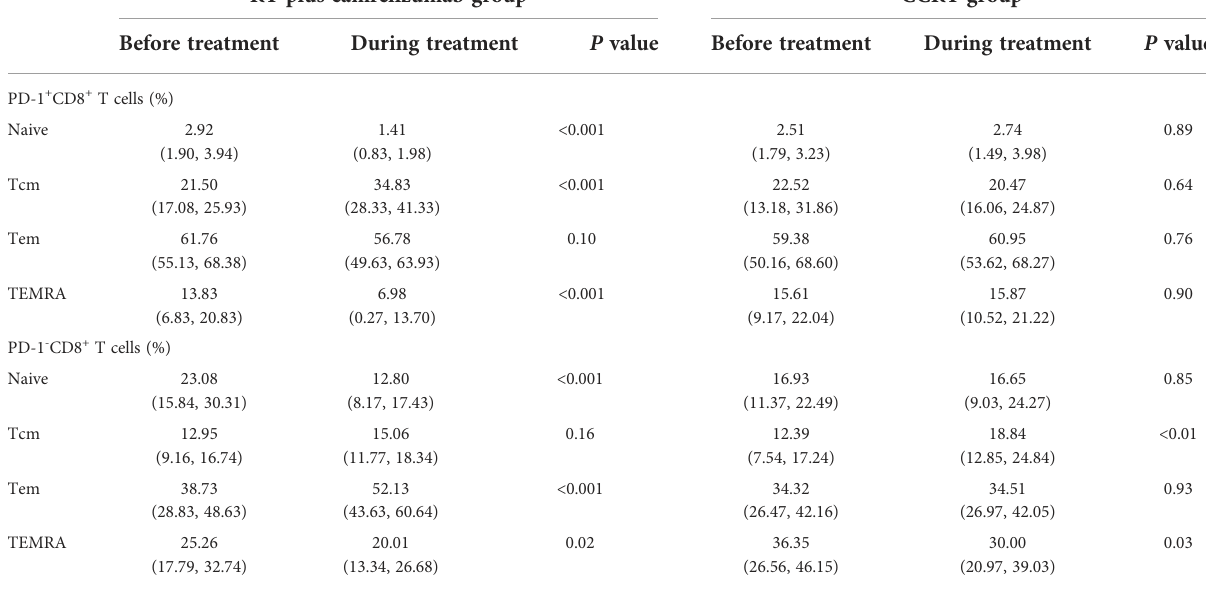
TABLE 4 Differentiation status in PD-1 + and PD-1 - CD8 + T